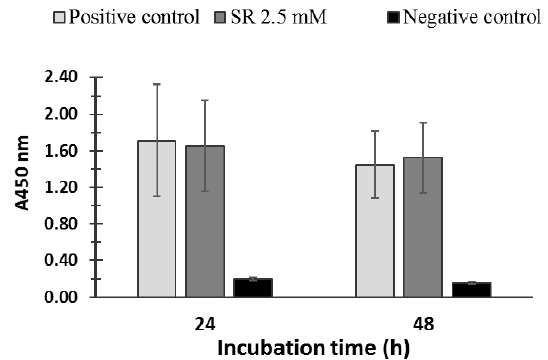
Figure 2. Cell viability of PBMCs incubated in the absence (positive control) and in the presence of 2.5 μ M SR for 24 h and 48 h was evaluated by using the WST-1 Cell Proliferation Assay (Roche, Basel, Switzerland). The negative control represents the cells treated with Triton X-100. No significant differences were found between the positive controls and the SR-incubated cells (for both 24 h and 48 h incubations p > 0.05).